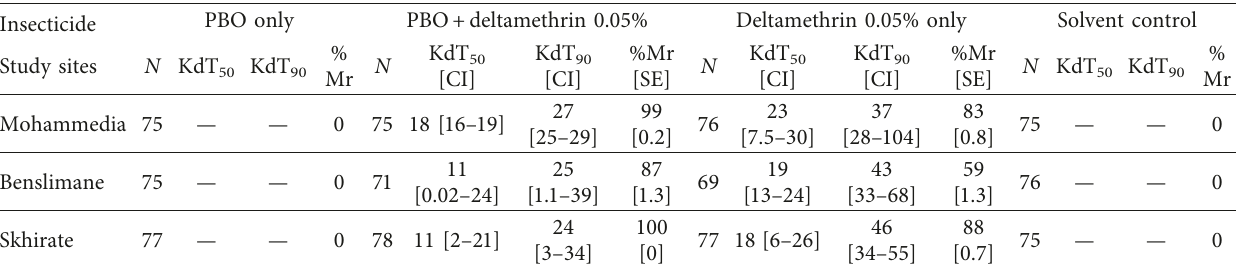
Table 3: Mortality rates of Culex pipiens with deltamethrin alone and deltamethrin +PBO in Mohammedia, Benslimane, and Skhirate, 24 hours after